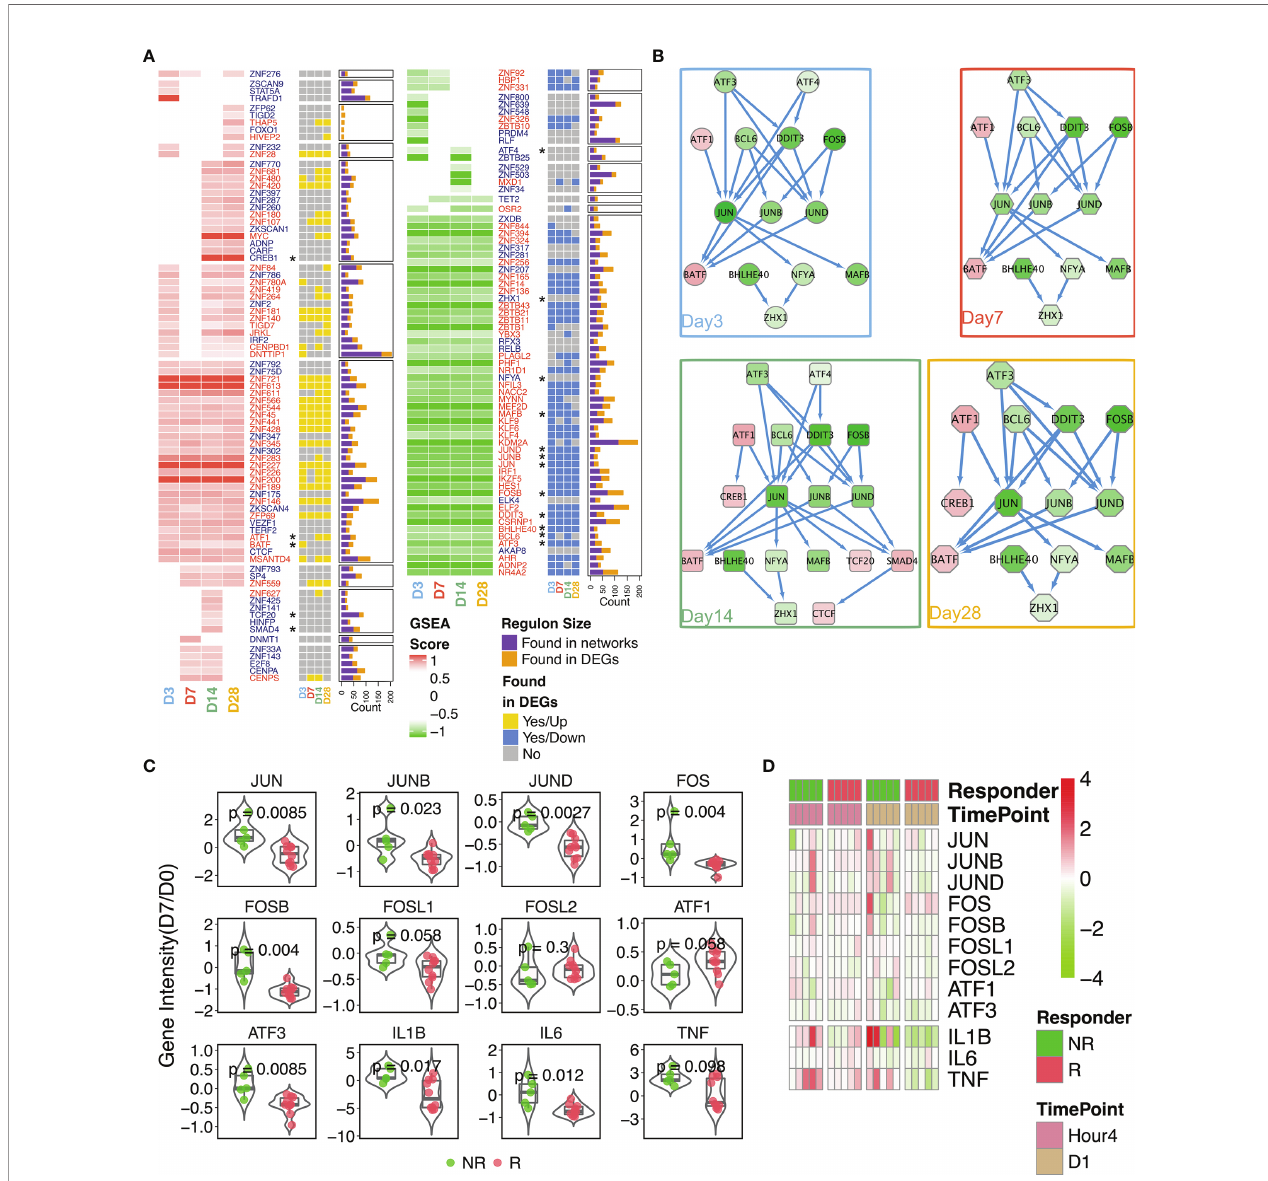
FIGURE 5 | Reconstruction of the transcriptional networks and analysis of master regulators. Transcriptional networks were reconstructed with the expression data in responders. (A) The identi fi ed transcriptional regulatory units were found via network reconstruction. Gene names are shown in red . A yellow square indicates that the differentially expressed gene (DEG) was upregulated on the designated time point, a blue square indicates that the DEG was downregulated on the designated time point, and a gray square indicates that the DEG was not signi fi cantly differentially expressed on the designated time point. The size of each regulon manipulated by each transcription factor (TF) is given in the stacked bar plot . Purple indicates regulons found through the network analysis; mustard indicates regulons present as the DEGs. Asterisks denote genes involved in the interaction network. (B) Protein – protein interaction network generated from TFs within responders. The time point- speci fi c network is shown in each colored box . Nodes are colored according to the log 2 fold change (day 14 compared to day 0). (C) Comparison of the expression intensities of selected genes on day 7 (baseline-normalized) in non-responders (NRs) versus responders (Rs). P -values were calculated using the Wilcoxon test. Each dot in the box – violin plot represents a single participant. (D) Fold change in the gene expressions (compared to baseline) of the AP-1 pathway-related genes at hour 4 and day 1